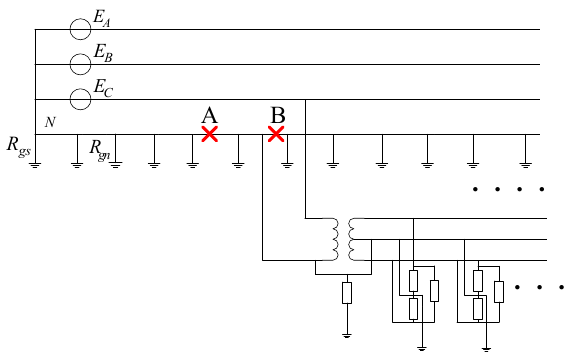
Figure 12. Two broken neutral points at both sides of the monitored service transformer.